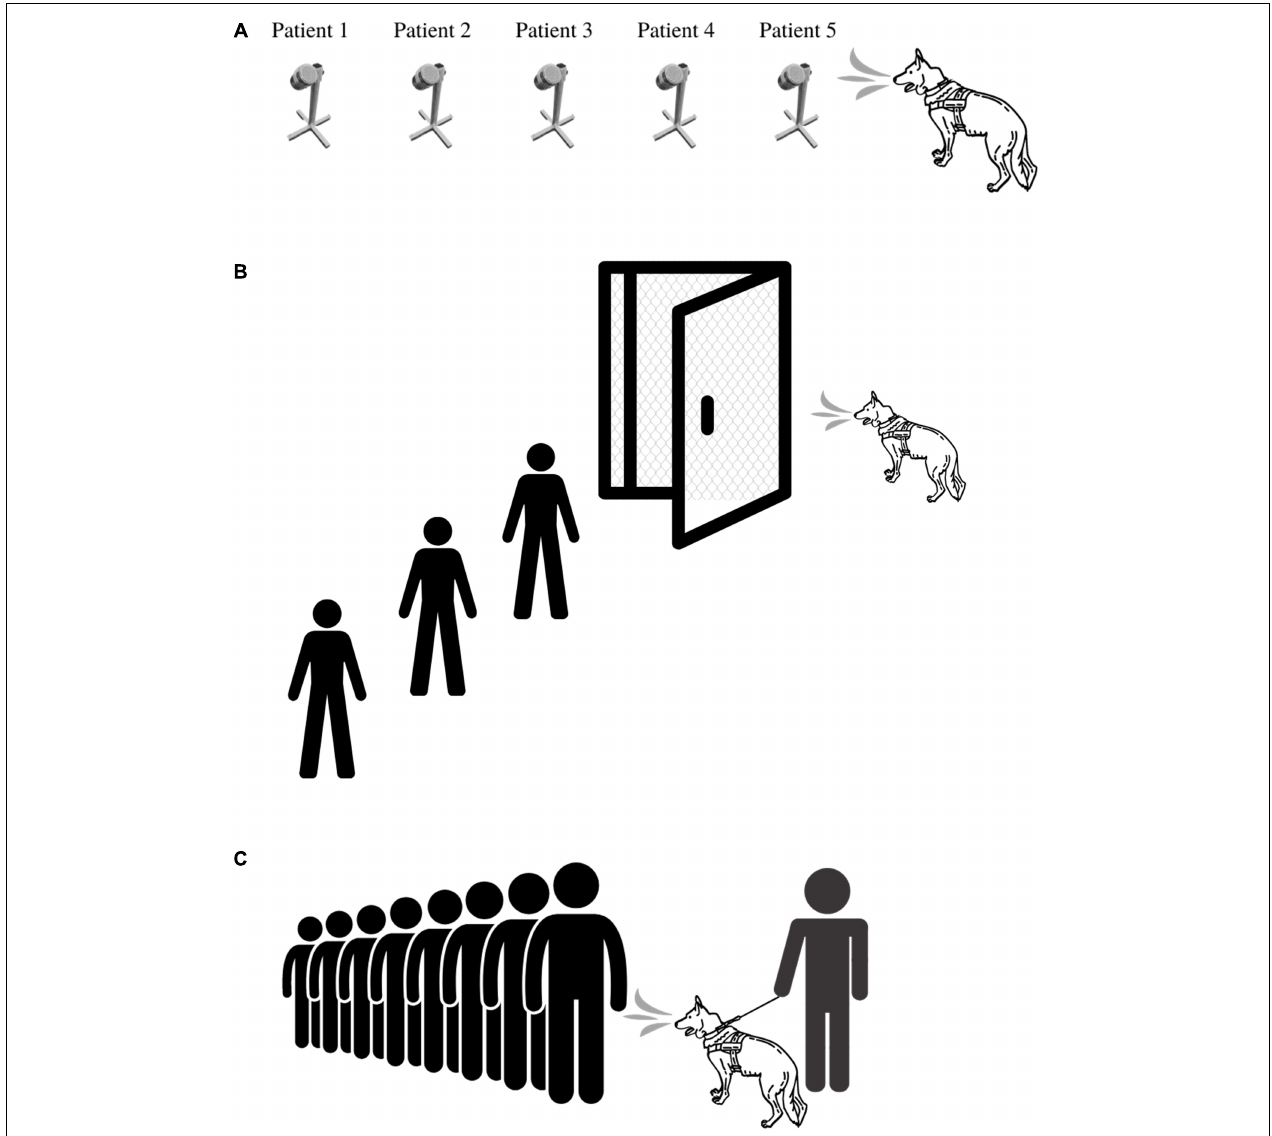
FIGURE 2 | BMDD deployment scenarios utilized during COVID-19 pandemic. (A) Deployment Scenario 1 illustrates the most basic of deployment scenarios in which a BMDD screens people or environmental samples in an area separated from the disease outbreak. (B) Deployment Scenario 2 illustrates BMDD people screening in the disease outbreak area, yet physically separated from the population. Here, the BMDD is separated by a mesh screen or high efficiency particulate air filter if needed and can screen people through a checkpoint or individually through a lineup or room. (C) Deployment Scenario 3 illustrates the most complex deployment scenario in which a canine team screens people either en masse or in a lineup by being able to directly sniff each individual or group of